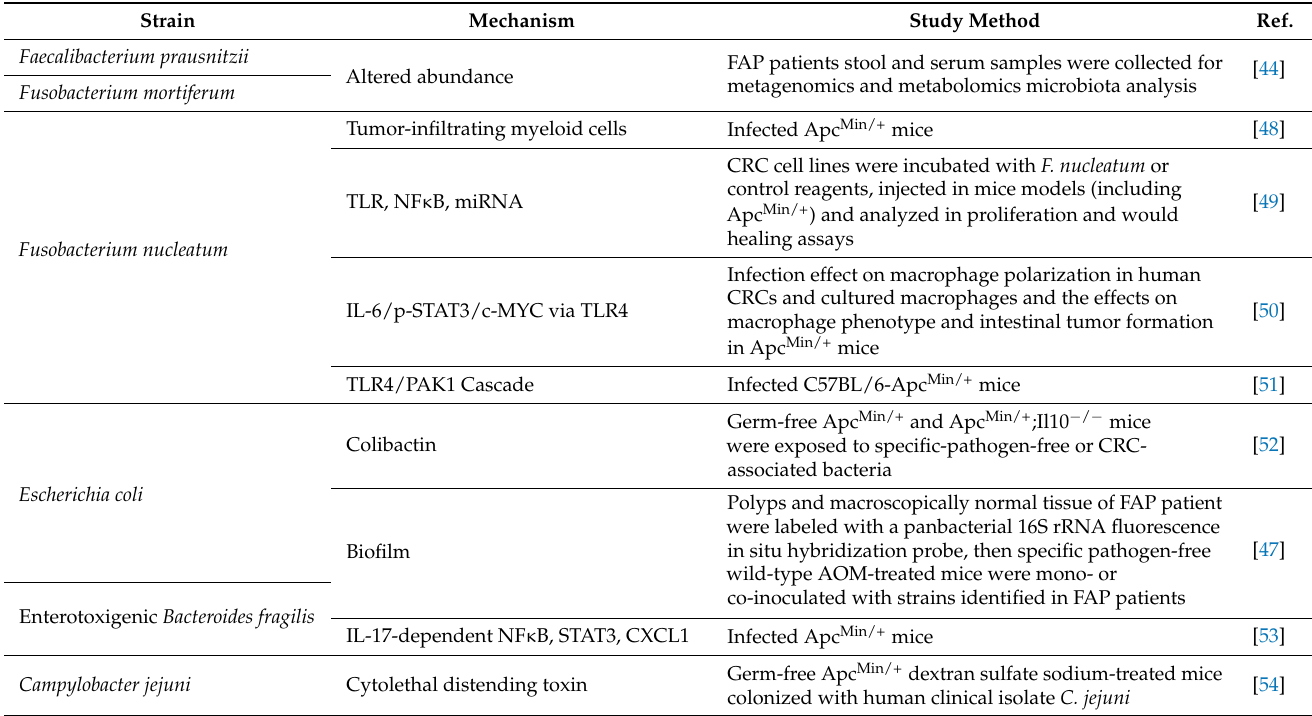
Table 1. Pathogenic bacteria in FAP mice models and